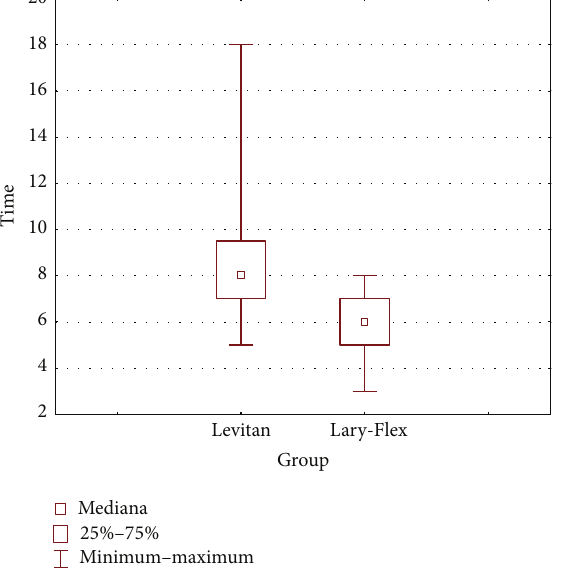
Figure 4: Time for intubation with studied devices (s).